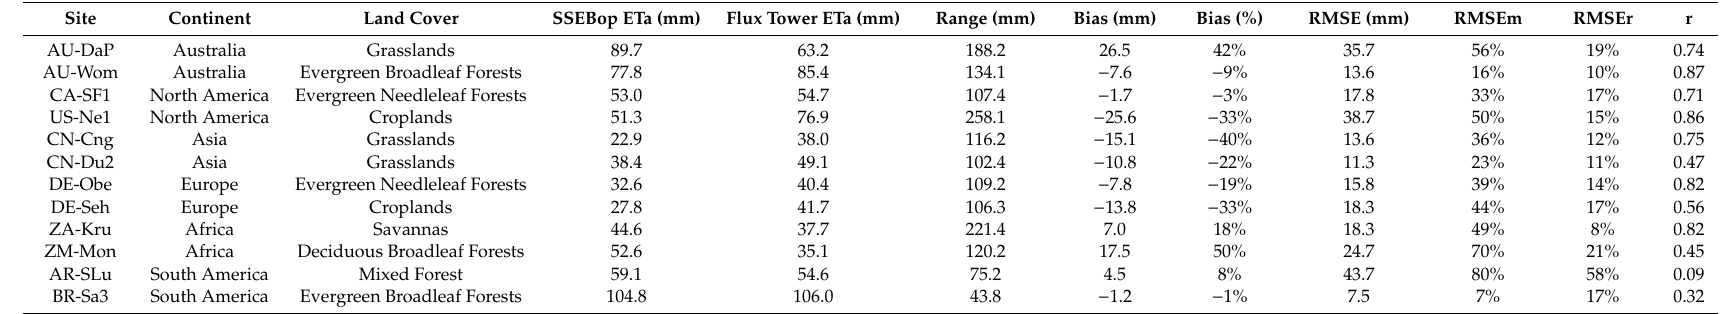
Table 3. Monthly comparison of SSEBop ETa and eddy covariance (EC) flux tower ETa for 12 sites globally for 2003–2014. ETa columns are mean values for all months available with matching pairs. RMSEm (%) is the RMSE divided by the mean of flux tower ETa, and RMSEr (%) is the RMSE divided by the range of flux tower ETa. Percent bias is the average di ff erence between the SSEBop ETa and flux tower ETa from matching pairs divided by the mean of EC flux tower ETa; r is the Pearson’s correlation coe ffi